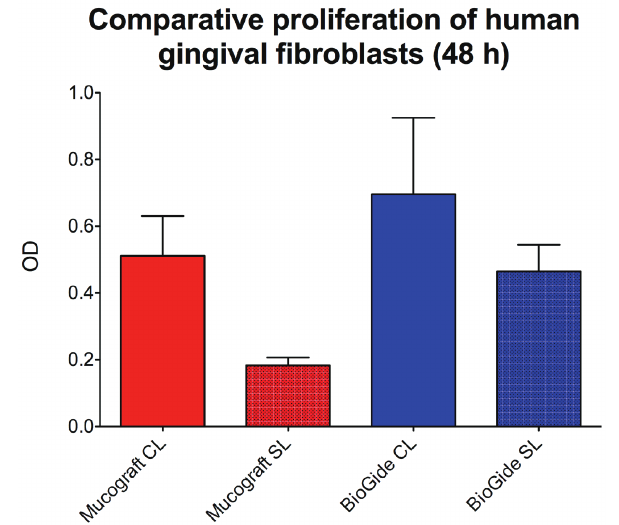
Figure 4- Results of the proliferation assay (WST-1 Test; means ± SD) after 48 hours with human gingival fibroblasts related to the two sides (CL=compact layer, SL=spongy layer) of Mucograft (MC) or BioGide (BG), and with cells without membranes (control groups MG and BG)